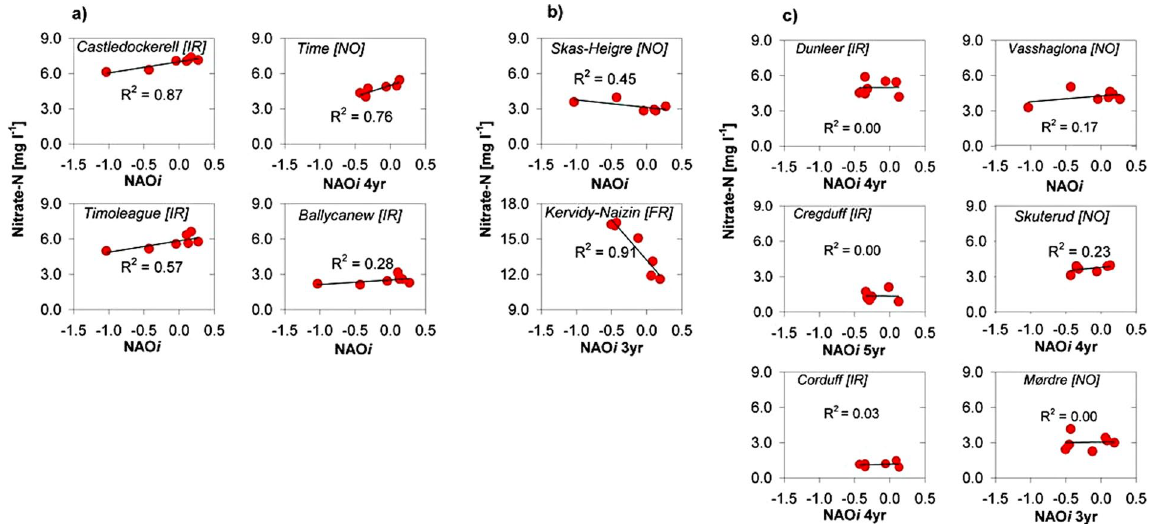
Figure 4. Linear correlation of nitrate-N concentrations in rivers to NAO i . Annual averages (hydrological years, October - September) of nitrate-N concentrations correlated to NAO i : ( a ) positive correlations, ( b ) negative correlations and ( c ) no correlations in Irish, Norwegian and French catchments with different flow controls, farm management, weather response to NAO change, N retention and storage capacity. NAO i are expressed as antecedent zero to five-year simple moving average depending on the specific catchment response time (there is no N concentration data for the Moulinet